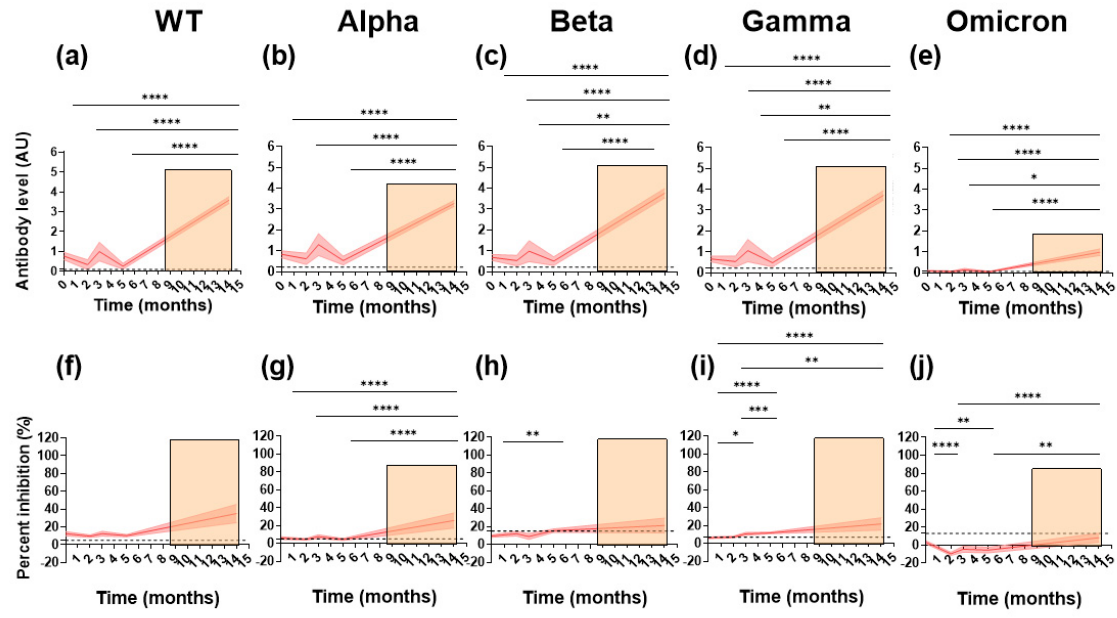
Figure 2. Longitudinal levels of binding and ACE2 competition against SARS-CoV-2 WT and the VoC in paucisymptomatic subjects. IgG binding (antibody level, AU, panels ( a – e )) and ACE2 inhibition (percent inhibition, %, panels ( f – j )) was measured longitudinally in paucisymptomatic subjects. The panels show cohort running means (thick red line) and their 95% confidence (red shading). Orange shading represents the time period in which subjects were vaccinated. A Kruskal–Wallace test and Dunn’s post-hoc test were performed between all possible combinations longitudinally (* p = 0.05, ** p = 0.01, *** p = 0.001 and **** p = 0.0001). Positivity cut-offs are represented by a dashed black line.